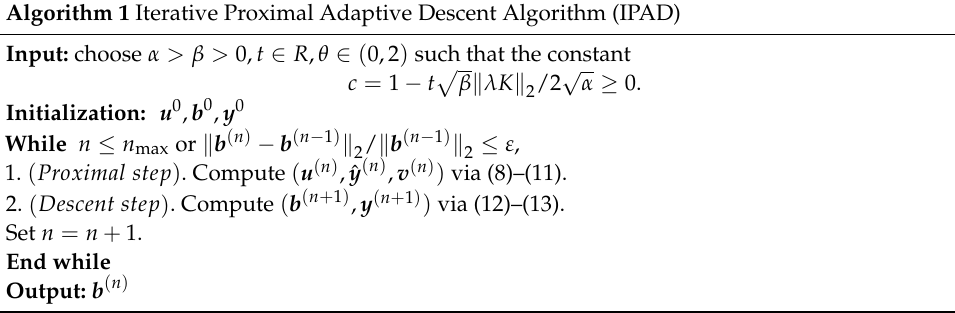
Algorithm 1 Iterative Proximal Adaptive Descent Algorithm